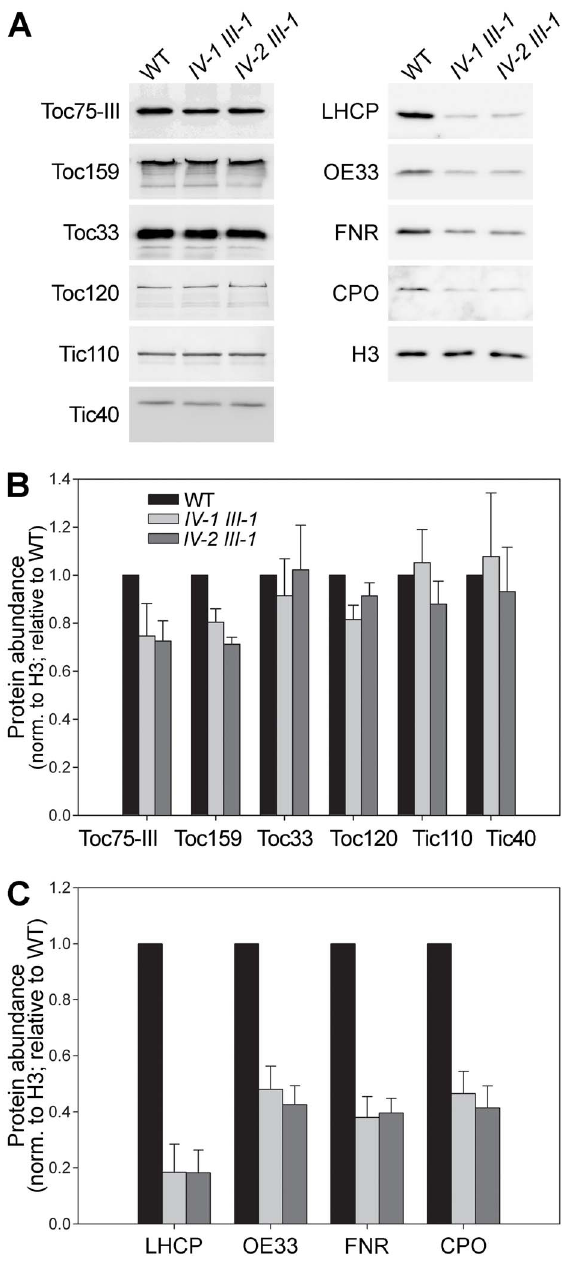
Figure 6. Chloroplast protein levels in the tic22 double mutants. A. Equal protein samples (20 m g) from 5-day-old homozy- gous, MS-grown plants of the indicated genotypes were analysed by immunoblotting using the antibodies shown. LHCP, light-harvesting chlorophyll-binding protein; OE33, oxygen-evolving complex 33 kD subunit; FNR, ferredoxin-NADP reductase; CPO, coproporphyrinogen oxidase; H3, histone H3. B,C. Chloroplast protein bands in A (as well as those from other, similar experiments) were quantified using Aida software (Raytest), and then the data were normalized using equivalent H3 data. Values shown are means ( 6 SE) derived from 3–8 independent measurements.